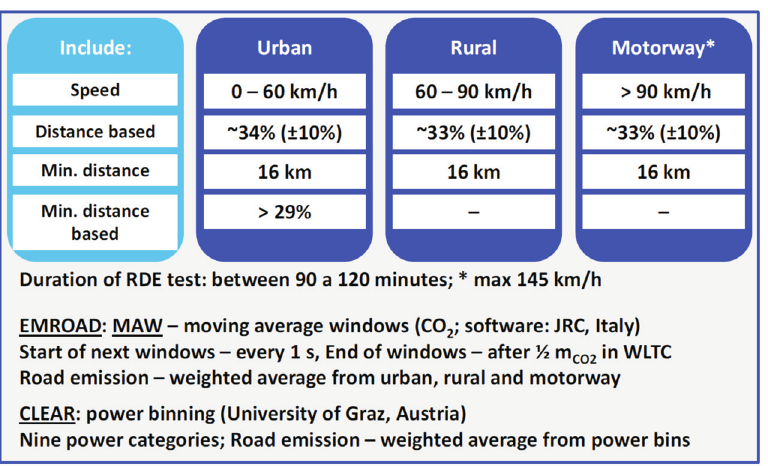
Fig. 2. Requirements of the test drive cycle